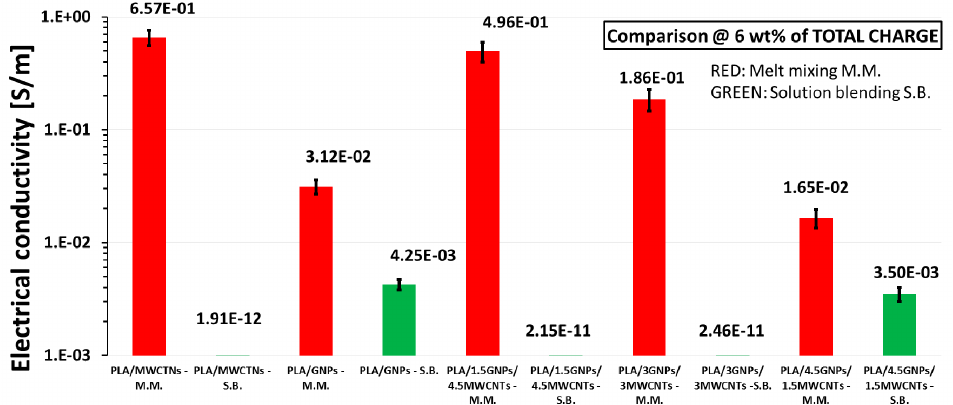
Figure 6. Comparison of electrical conductivity at the highest filler amount (i.e., 6 wt %).